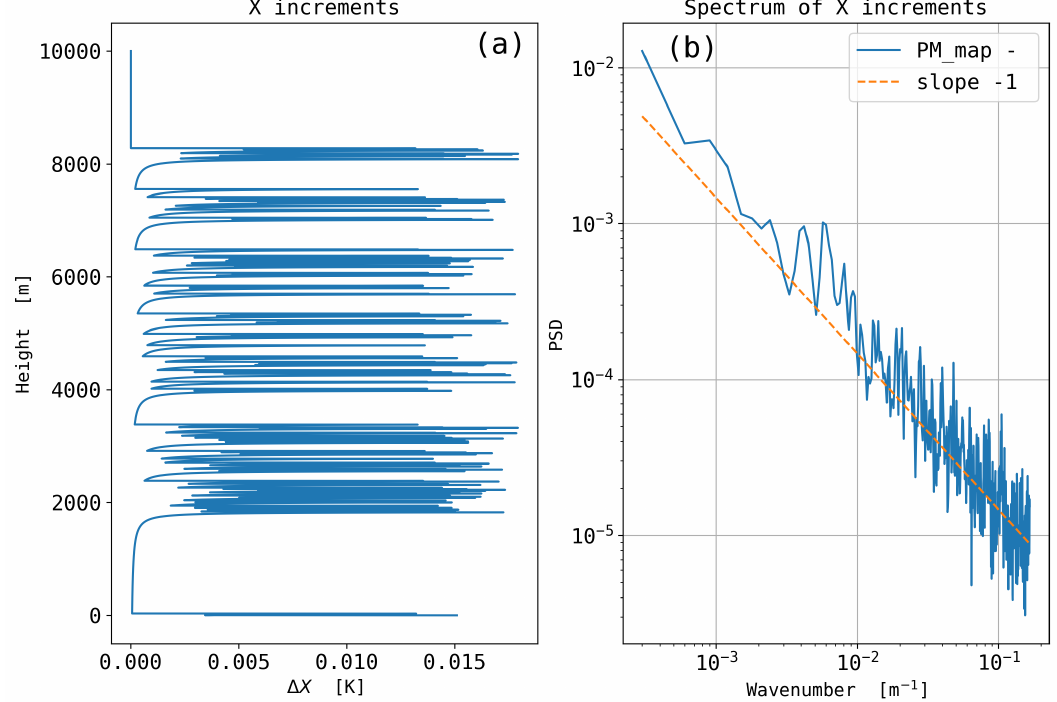
Figure A3. ( a ) Sequence of positive increments produced with the Pomeau-Manneville map (see text). ( b ) The corresponding power spectrum of increments. A − 1 slope is shown for